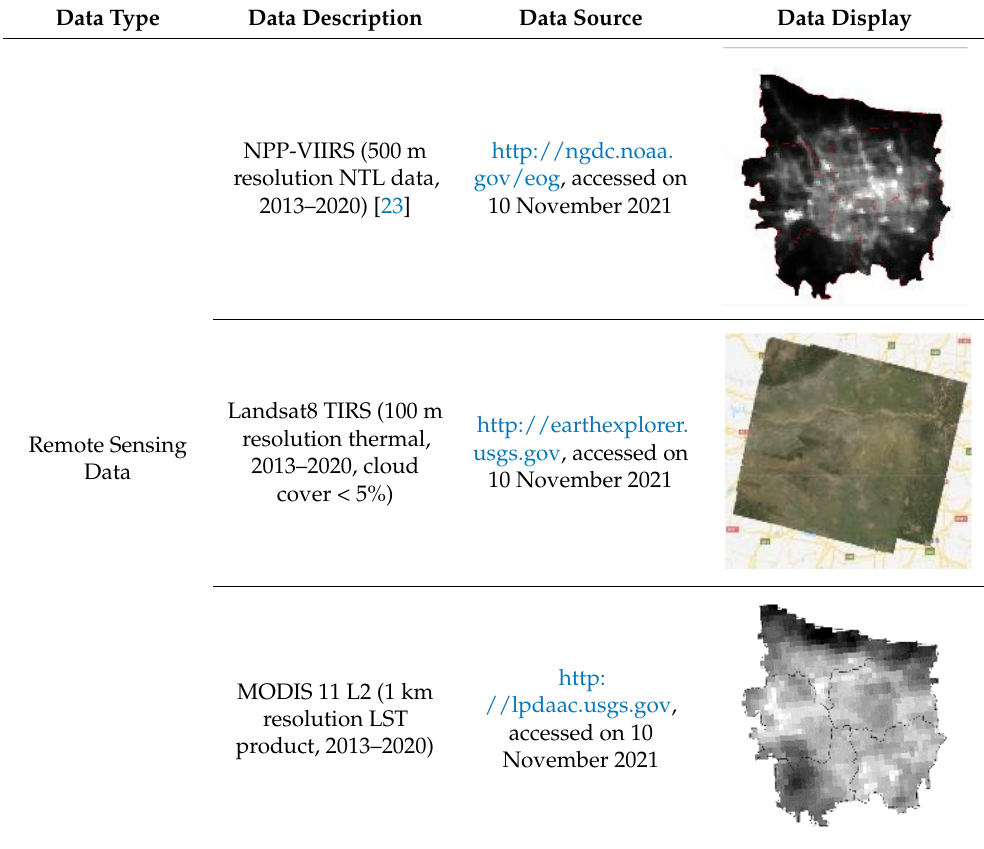
Table 1. Data sources.